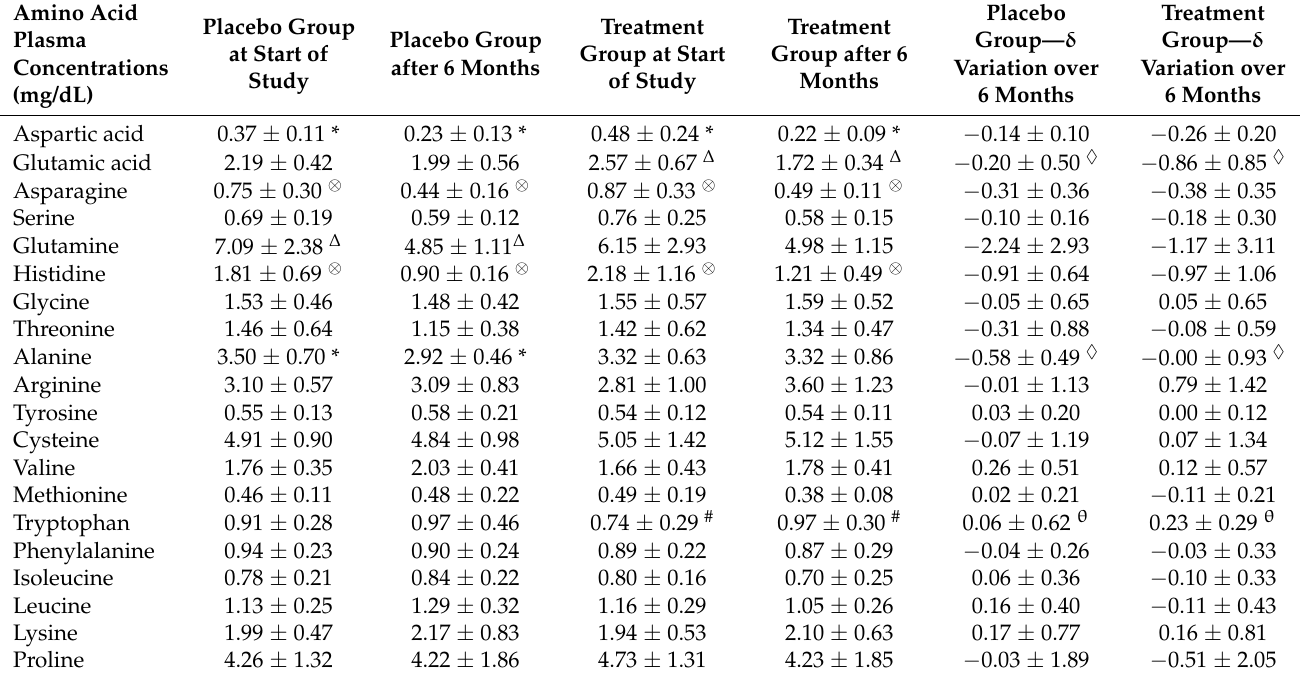
Table 1. Mean plasma concentrations of amino acids in treatment and placebo groups and differences observed in temporal inter-study ( δ ) and intra-study group